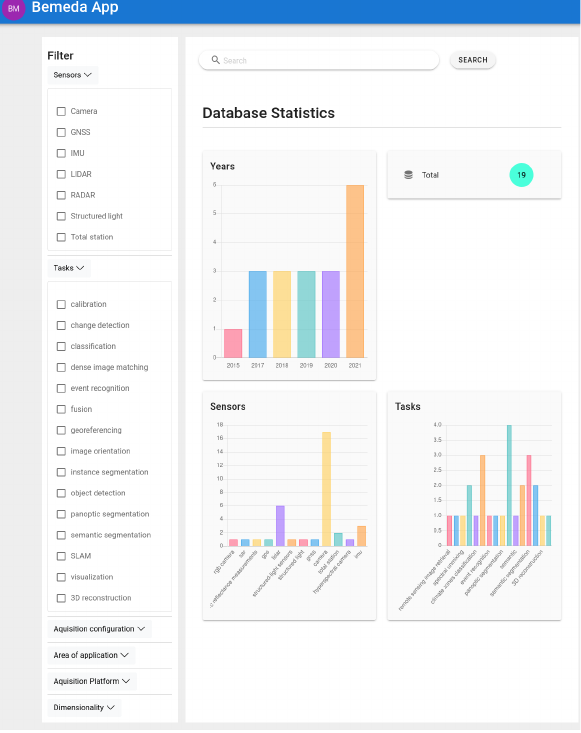
Figure 4. Example of our Front-End Application visualizing some statistics about the distribution of different parameters of -